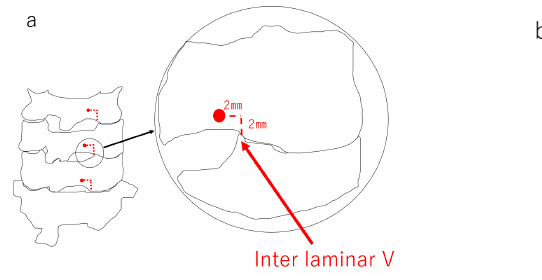
Figure 1. ( a ) Insertion point. Lateral margin between the vertebral arches (Inter laminar “V”). ( b ) Sagittal cross-sectional image of screw insertion using the screw as a reference. ( c ) Axial cross-sectional image of screw insertion using the screw as reference.